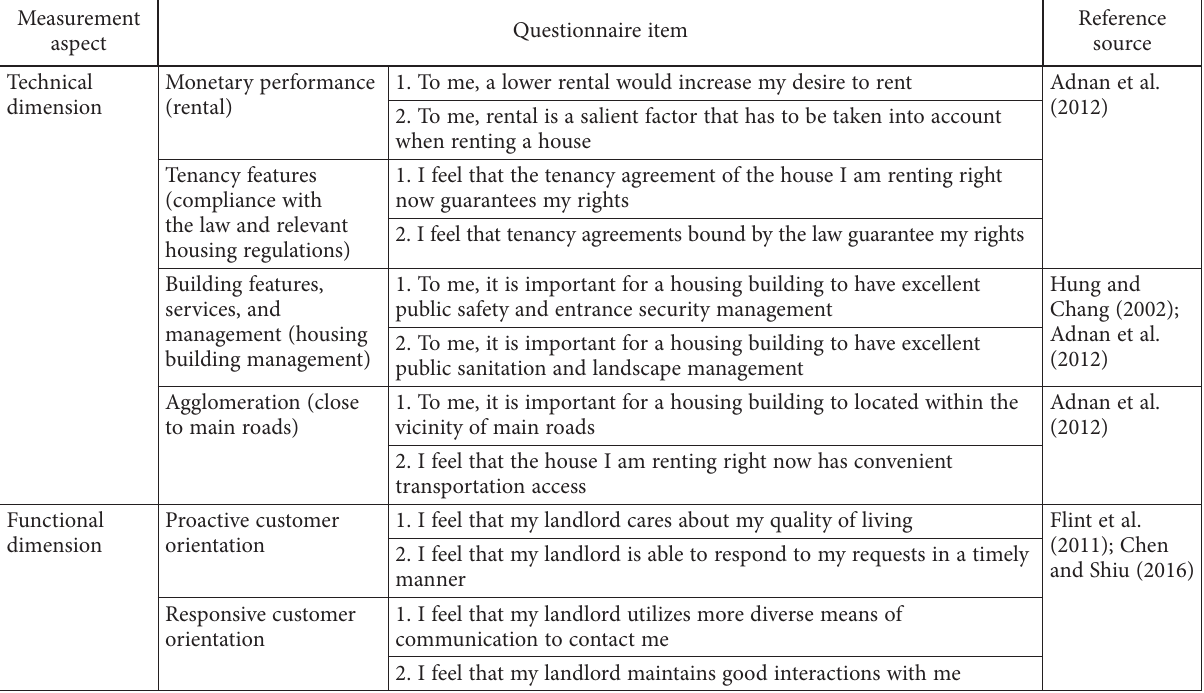
Table 1. Questionnaire items and reference